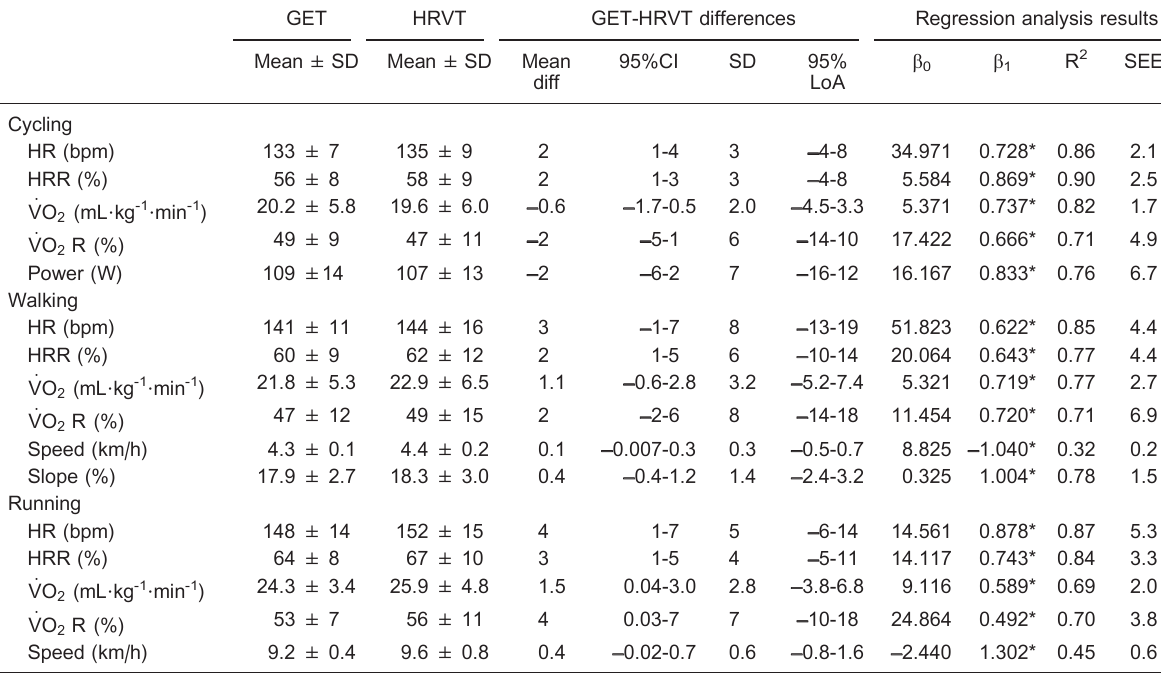
Table 2. Mean±SD values for HR, %HRR, relative exercise, as well as relevant statistics for GET-HRVT